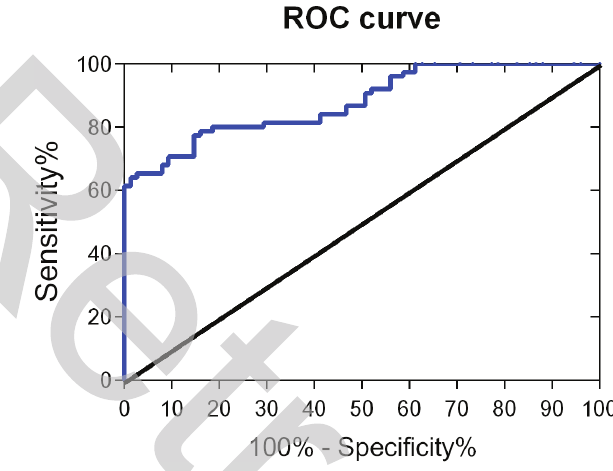
Figure 2 - The AUC for diagnostic efficiency of serum miRNA-378 in re- nal cell carcinoma (RCC)